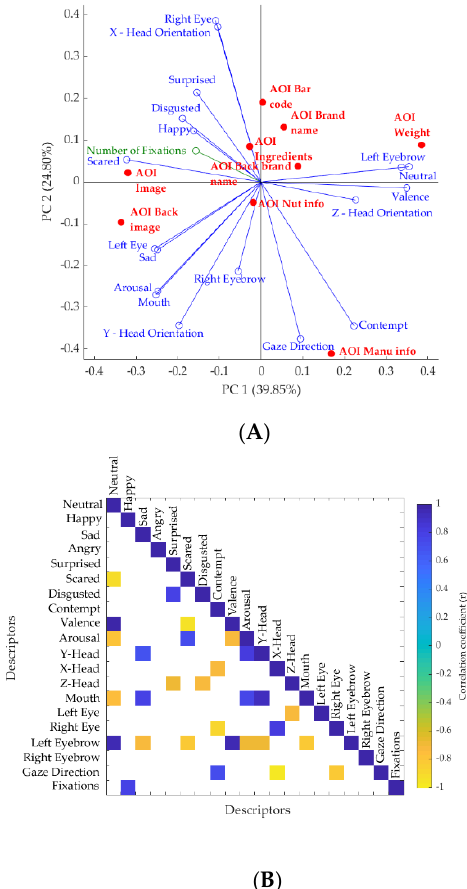
Figure 7. Results of ( A ) principal component analysis (PCA) and ( B ) correlation matrix of the FaceReader ™ (FR) outputs and fixations from eye tracking against the area of interests (AOIs) of familiar packaging concepts. Red / square: AOI, green vector: fixations from eye tracking, blue vector: FR outputs. The x-axis represents the principal component 1 (PC1), and the y-axis represents the principal component 2 (PC2) in the PCA. Abbreviations: AOI, area of interest; Manu info, manufacturer’s information; and Nut info, nutritional information.